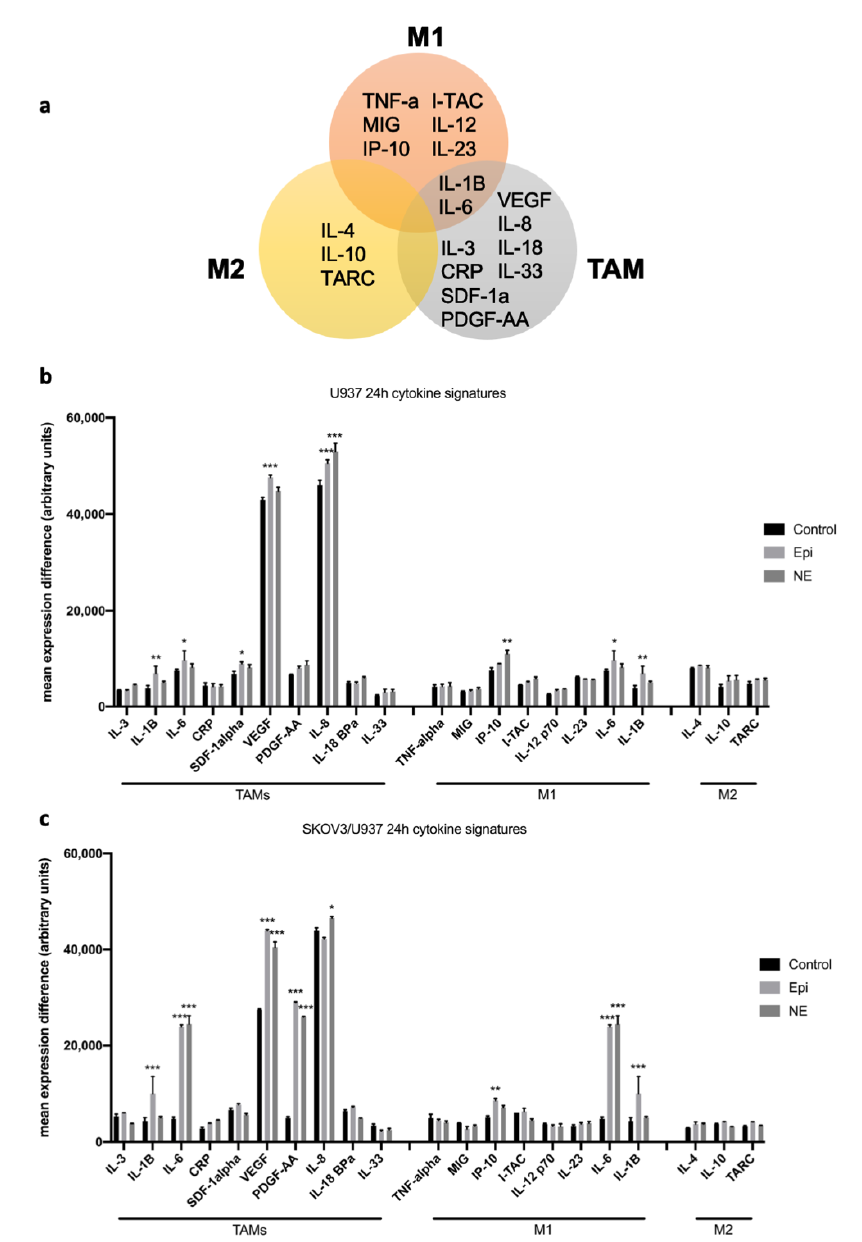
Figure 3. Cytokine signatures associated with Tumor-associated macrophages (TAMs), M1, and M2 phenotypes in U937 monocultures and SKOV3ip1 / U937 co-cultures. ( a ) Schematic representation of cytokine signatures categorized by macrophage subsets. ( b ) Cytokine expression signatures in U937 monocultures and ( c ) SKOV3ip1 / U937 co-culture conditions after 24-hr exposure to Epi or NE. Mean ± SEM. * p < 0.05 ** p < 0.01 *** p < 0.0001.